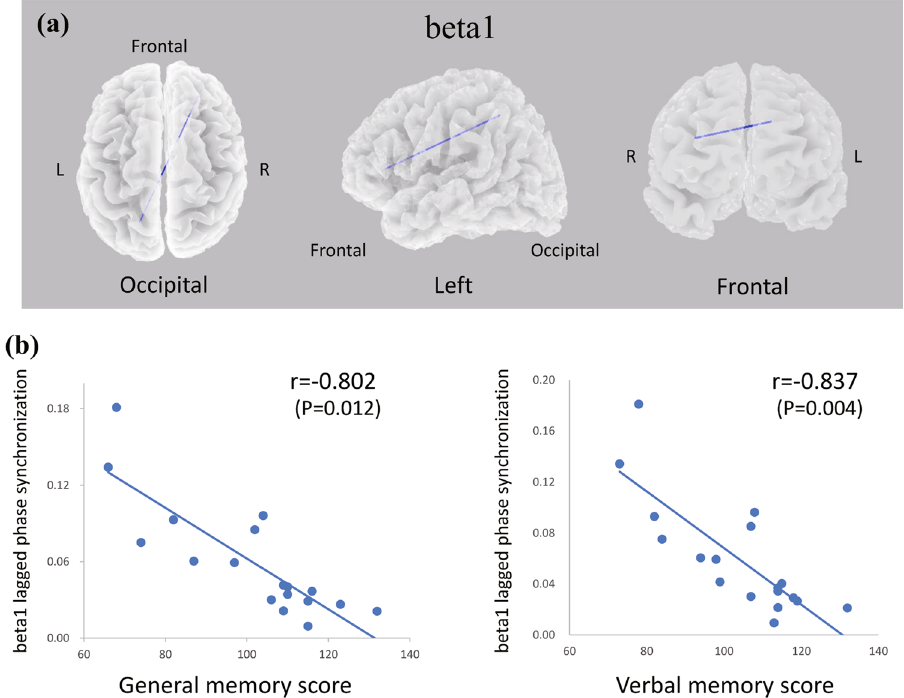
Figure 3. Association between lagged phase synchronization and general memory and verbal memory scores by eLORETA. ( a ) eLORETA wire diagrams of the right anterior prefrontal cortex (raPFC) and left superior parietal lobule (lSPL) show significant negative correlations with general memory (GM) and verbal memory scores in beta1 lagged phase synchronization (LPS). The blue line indicates connectivity between raPFC and lSPL, with a significant negative correlation between GM and verbal memory scores and beta1 LPS. ( b ) Scatter plots of GM and beta1 LPS values, verbal memory scores and beta1 LPS value intensities for 18 subjects.